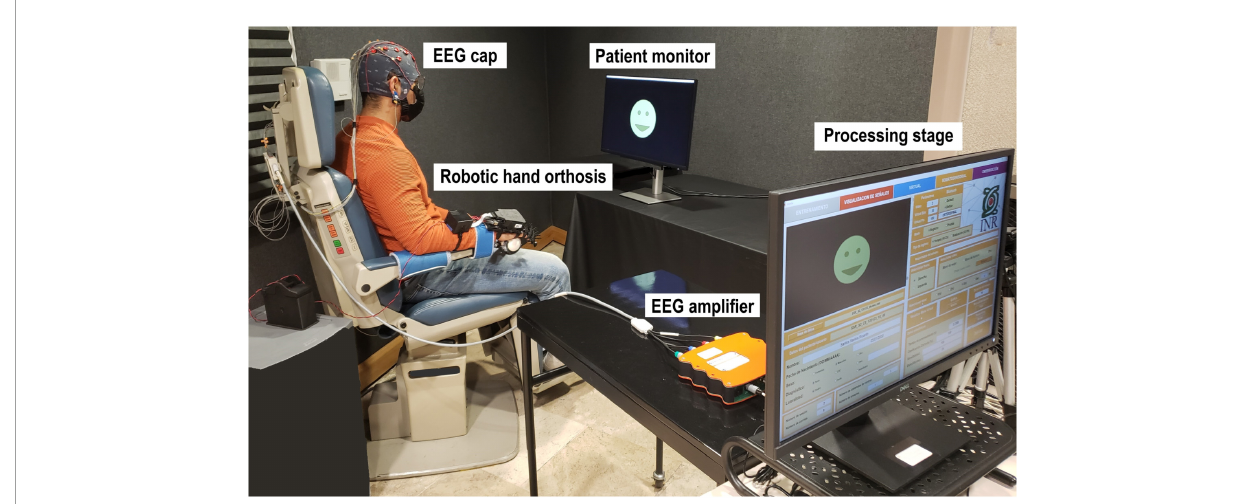
FIGURE1 Brain-computer interface setup employed for the experiment. A participant is shown while attempting to control the robotic hand orthosis using motor imagery.